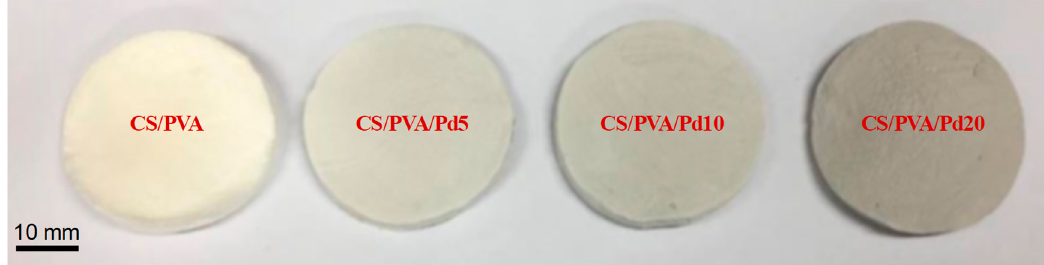
Figure 2. Photograph images of dressings.